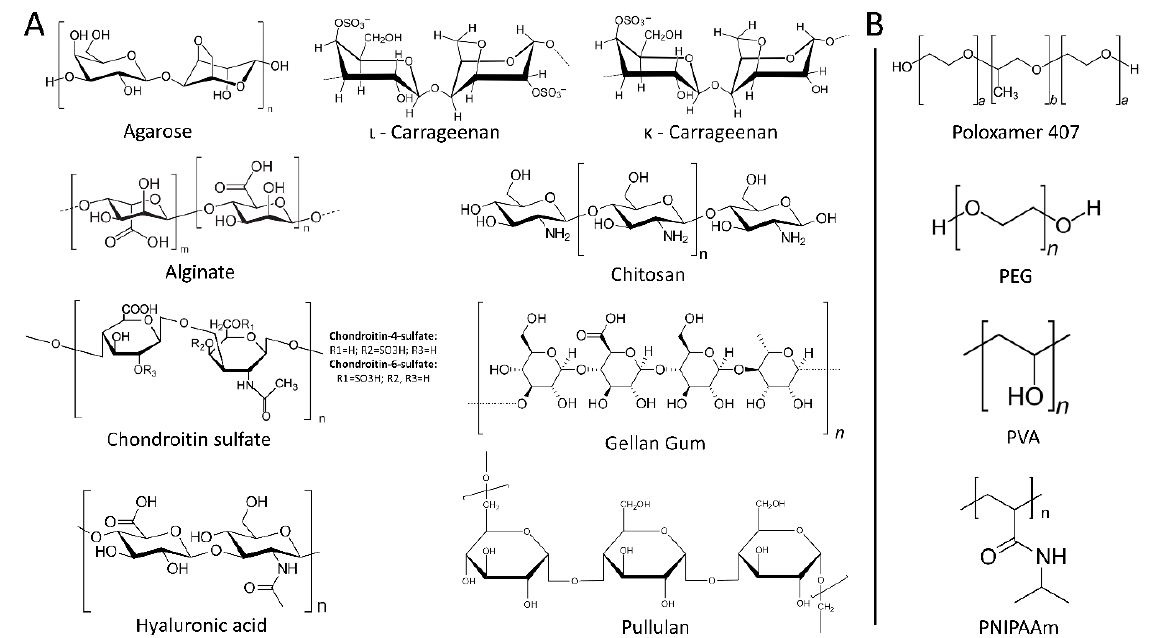
Figure 2. Chemical structures of natural ( A ) and synthetic ( B ) hydrogels.